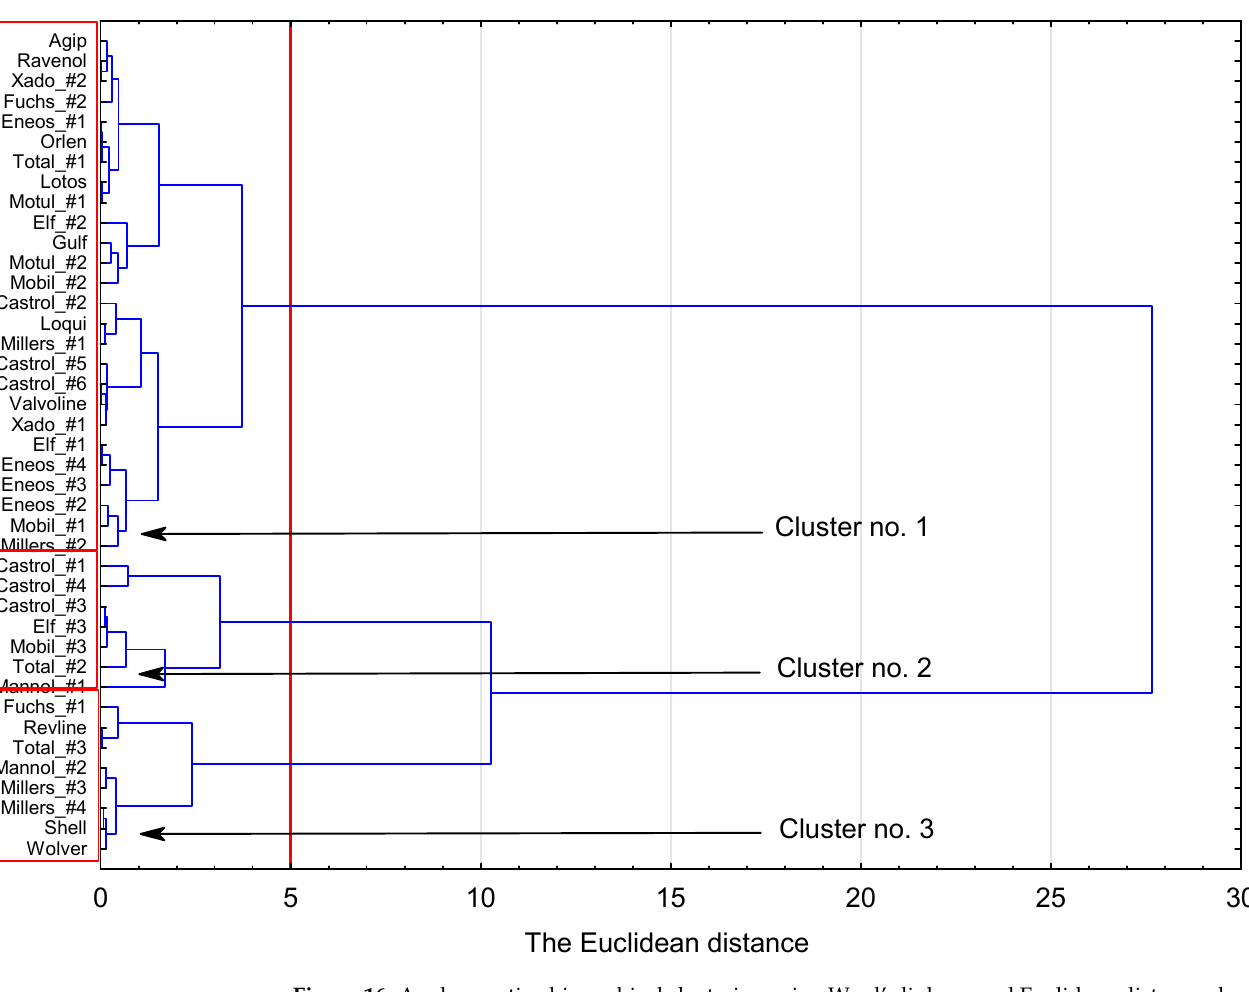
Figure 16. Agglomerative hierarchical clustering using Ward’s linkage and Euclidean distance - based on the TAN and TBN readings.